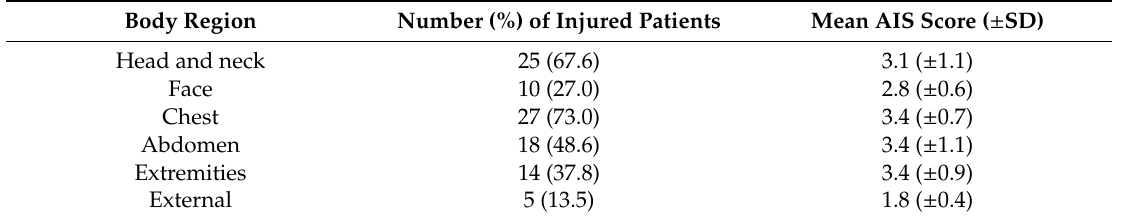
Table 2. Injury pattern and severity. Abbreviated injury scale